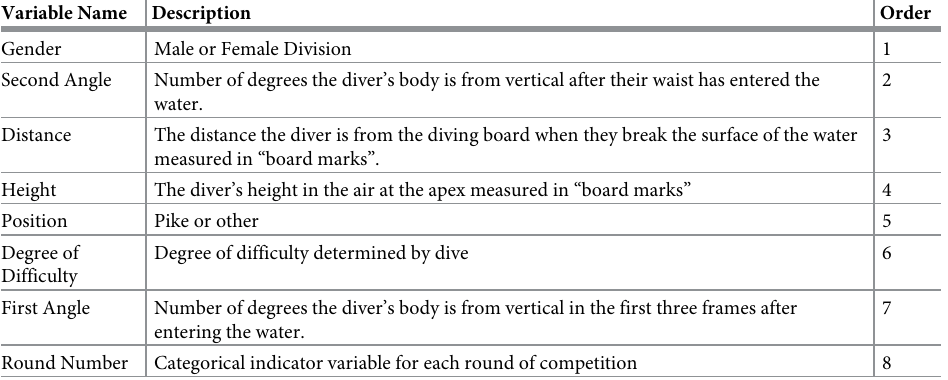
Table 1. Description of variables and the order they were added to the regression model.